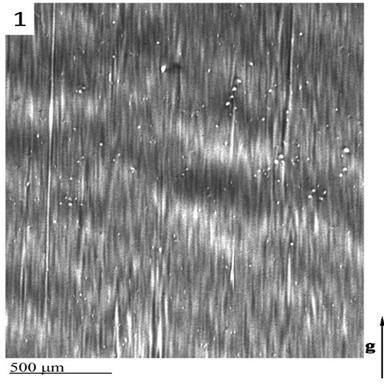
High magnification x-ray grazing incidence topograph from boxes in Fig. 4 showing threading dislocation contrasts as bright or dark dot shapes of various dimensions. The threading dislocation density was measured to be (1) 5.9 × 103 cm− 2 ; (2) 6.5 × 103 cm− 2 ; (3) 3.6 × 103 cm− 2 ; (4) 5.2 × 103 cm− 2 ; (5) 4.6 × 103 cm− 2 and the average is 5.16 × 103 cm− 2 .